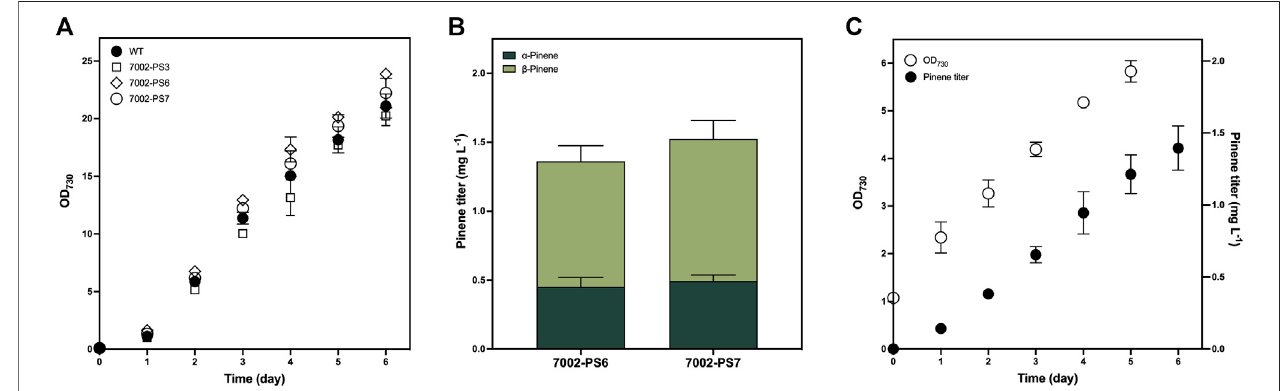
FIGURE3| Growth andpinene productionofthe7002-PS strain. (A) PhotoautotrophicgrowthoftheWTstrainand threeindependent transformantsofthe7002- PS strain grown with 1% ( v / v ) CO 2 aeration at 0.12 vvm for 6 days. Samples were collected for the analysis at 1-day intervals. (B) Pinene production of 7002-PS6 and 7002-PS7aftera72-hcultivationwith10%( v / v )dodecaneoverlayand1%( v / v )CO 2 aerationat0.12 vvm. (C) Photoautotrophicgrowthandpineneproductionof7002- PS7 grown with 10% ( v / v ) dodecane overlay and 1% ( v / v ) CO 2 aeration at 0.03 vvm for 6 days. Samples were collected for the analysis at 1-day intervals. The growth parameters were monitored by OD 730 , and the pinene titers were analyzed on a gas chromatography – mass spectrometer (GC-MS). The error bars represent standard deviations of means (mean ± SD, n (cid:2)